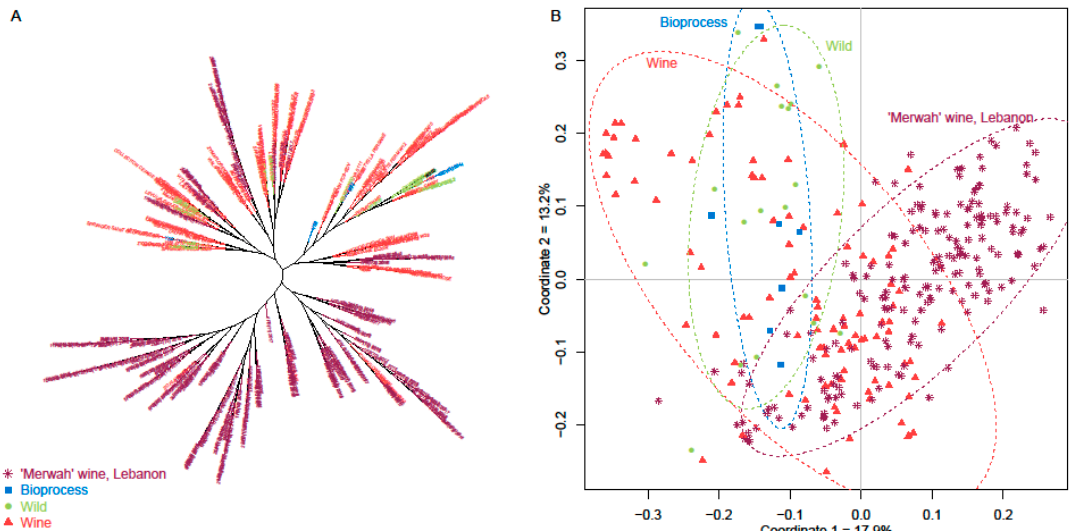
Figure 4. TREE-MULTIDIMSCALE. Population analysis of the 334 S. cerevisiae strains using 12 microsatellites. ( A ) Dendrogram using Bruvo’s distance and neighbour-joining clustering. ( B ) Multidimensional scaling. Coordinates 1 and 2 explain 17.9% and 13.2% of the variation. The strains from the different isolations are represented by different colours: bioprocess strains (blue), wild strains (green), wine strains (red) and Lebanon ‘Merwah’ wine strains (purple).